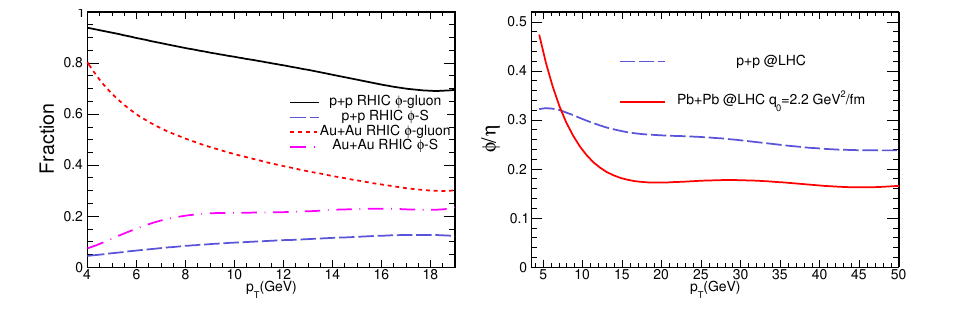
Figure 4. Left: gluon and quark contribution fractions to the total φ yields in p + p and in Au + Au at the RHIC [14]. Right: the ratio of φ/η as a function of p T in p + p and Pb + Pb collisions at the LHC